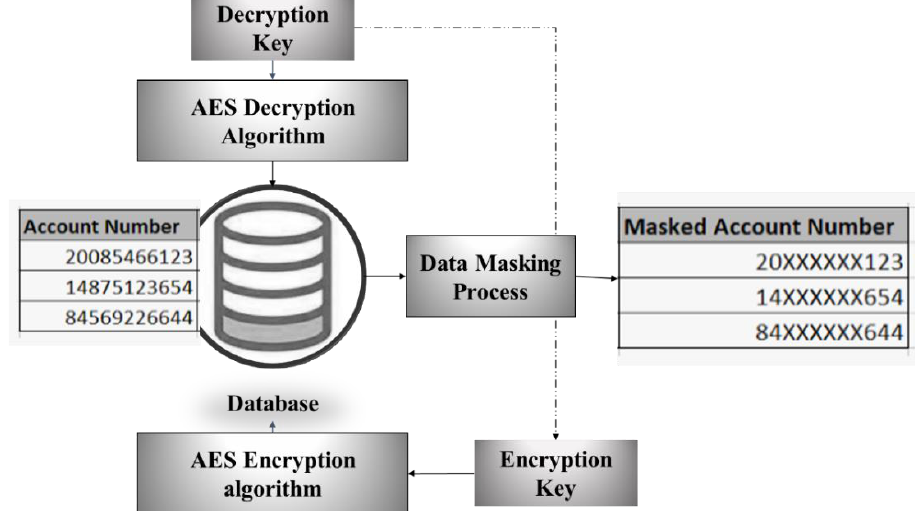
Figure 3. Hybrid data obfuscation for security.